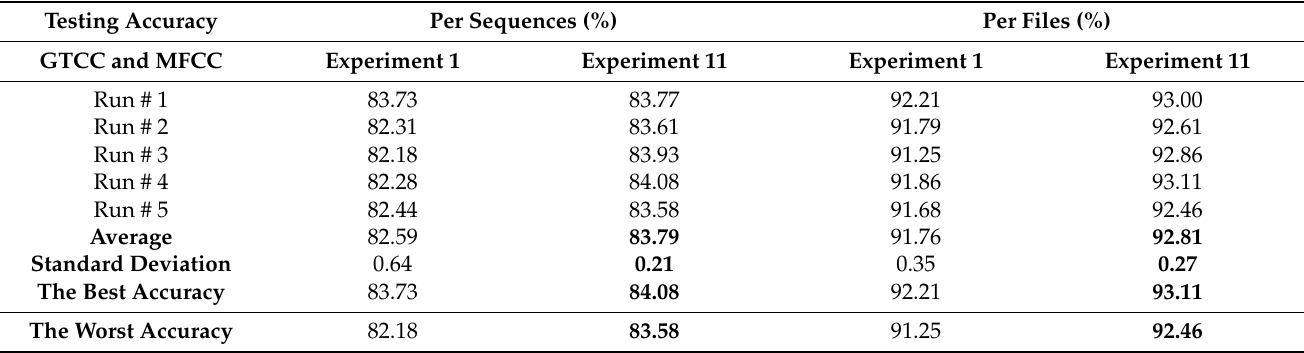
Table 6. Summary results for selected